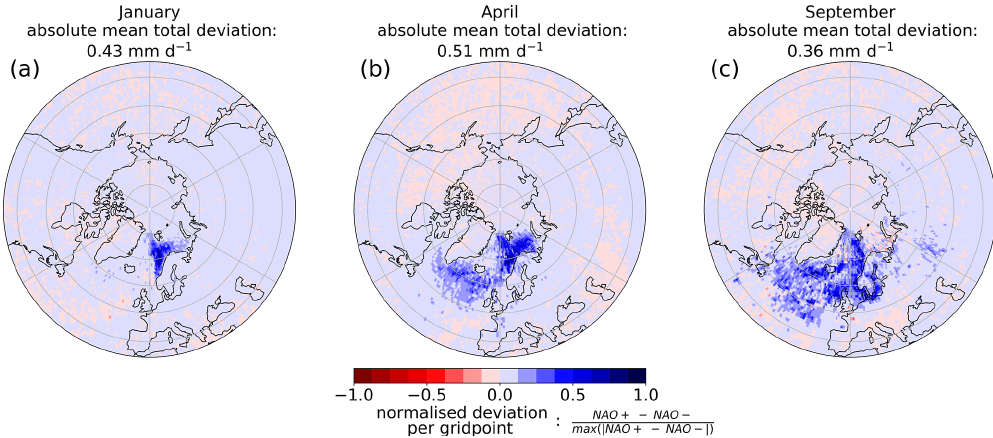
Figure 11. Normalised moisture source deviation between months with NAO indices being above or equal to the 75th percentile (NAO + ) and months being below or equal to the 25th percentile (NAO − ). The same thresholds as in Fig. 9b were chosen. To better compare the moisture source deviations they were normalised by dividing each grid point by the maximum difference between the months with NAO + and the months with NAO − , which gives the grid point with the largest positive difference a normalised deviation of 1.